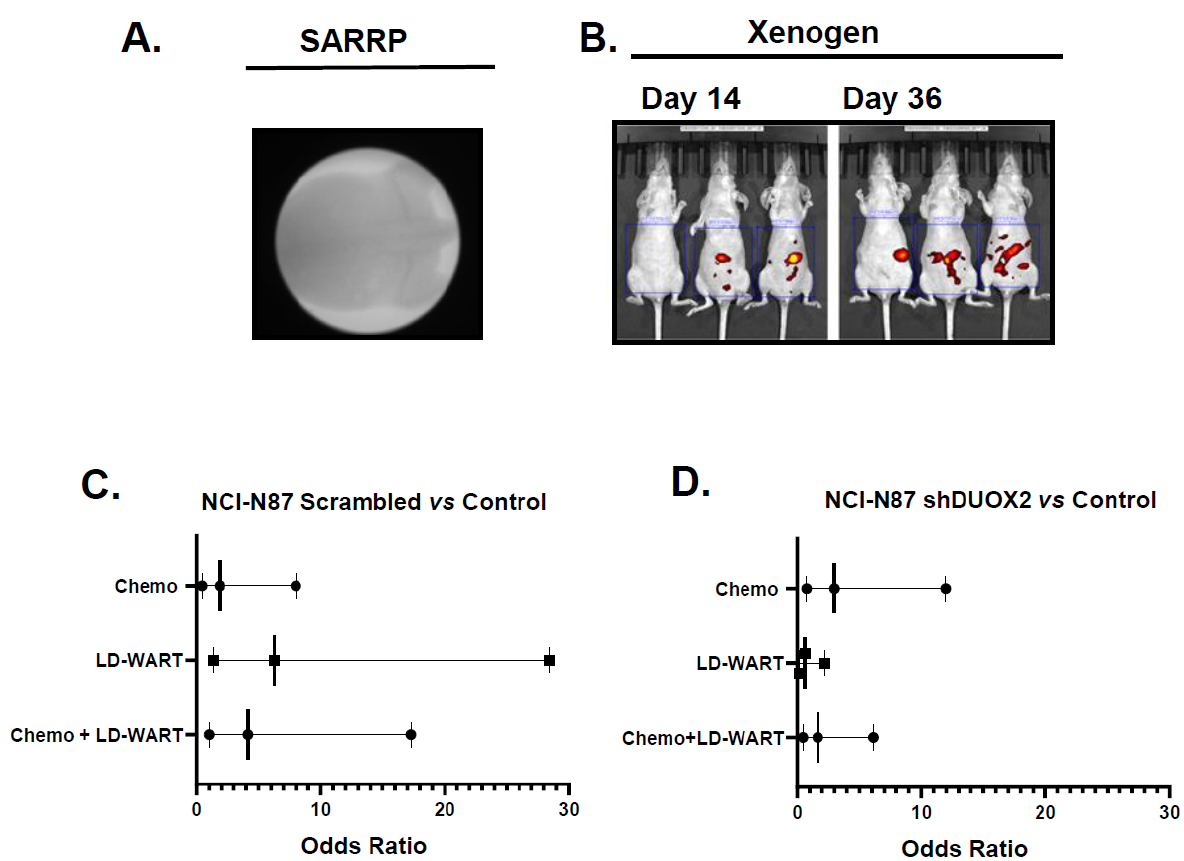
Figure 2. ( A ) Representative image obtained with a SARRP’s portal camera to verify field placement of irradiated field (whole mouse abdomen). ( B ) Representative fluorescence image (closed abdomen) obtained with a Xenogen IVIS optical imager on day 14 and 36 post-injection of human gastric cancer cells stably transfected with pGFP-C-shDUOX2 lenti. ( C , D ) Odds of reducing cancer dissemination as measured by fluorescence intensity being less than 25% of the intensity of day 1 at day 45. ( C ) Odds of tumor expressing endogenous DUOX2 levels treated with the indicated treatment compared to untreated animals. ( D ) Odds of tumor expressing reduced DUOX2 levels treated with the indicated treatment compared to untreated animals. n = 7–8.